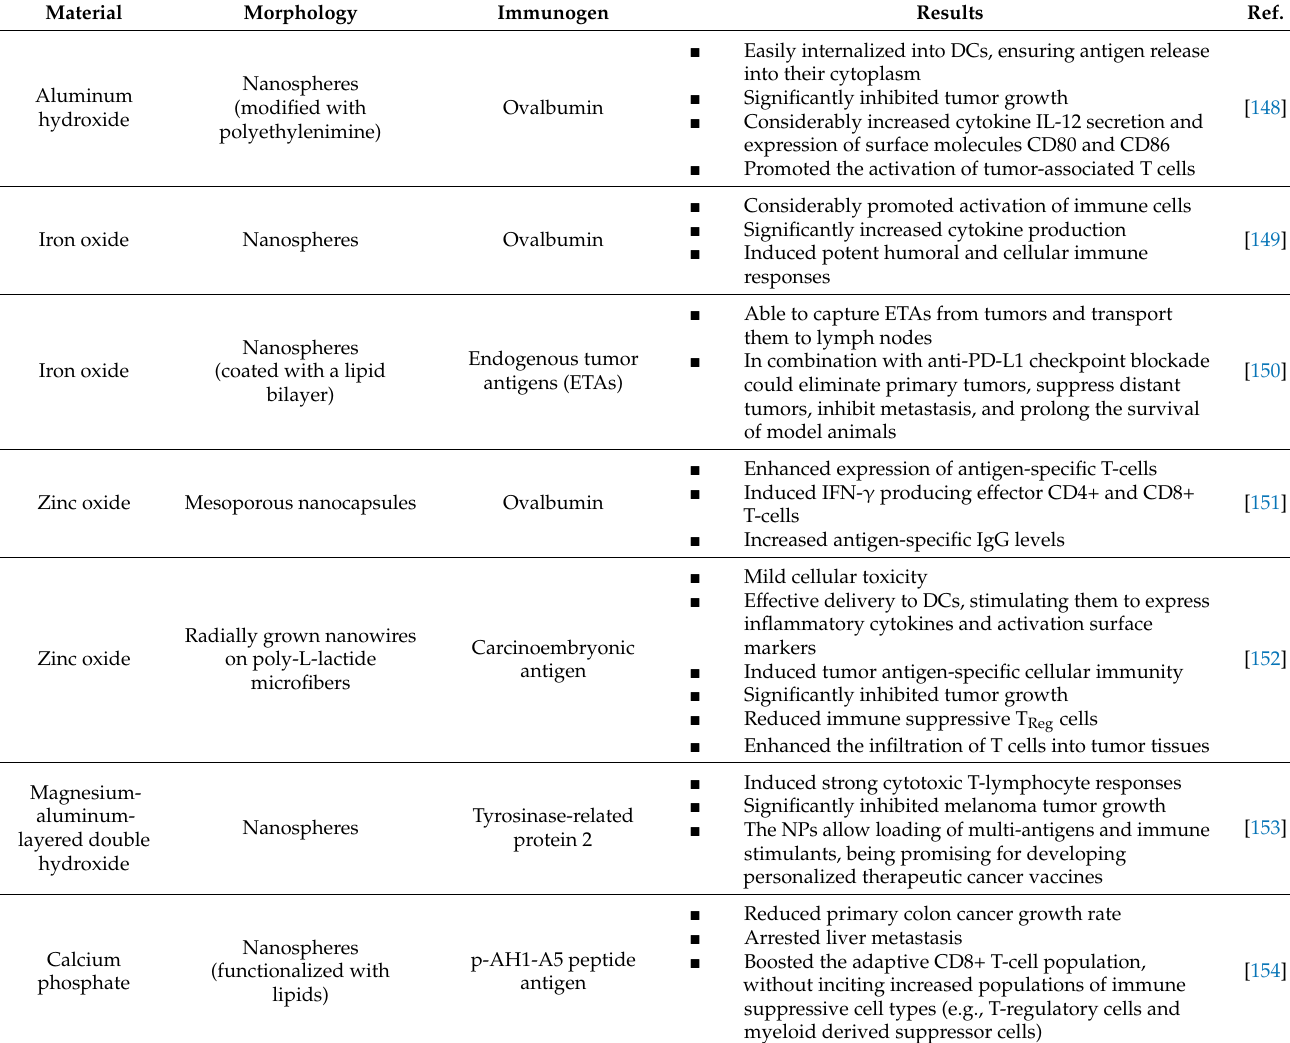
Table 3. Examples of metal-based nanomaterials for cancer vaccine